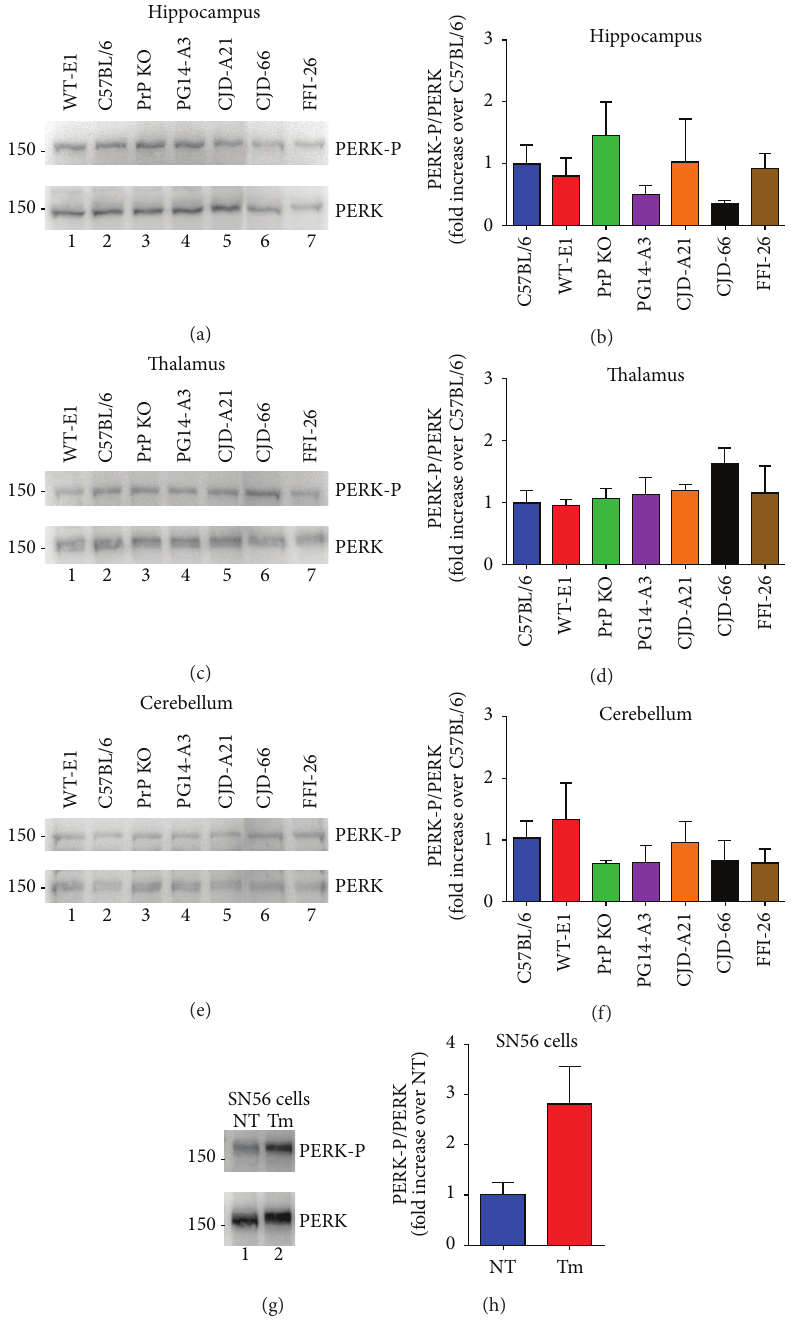
Figure 2: Phosphorylation of PERK is not increased in the brains of mutant PrP mice. Phosphorylation of PERK was evaluated in